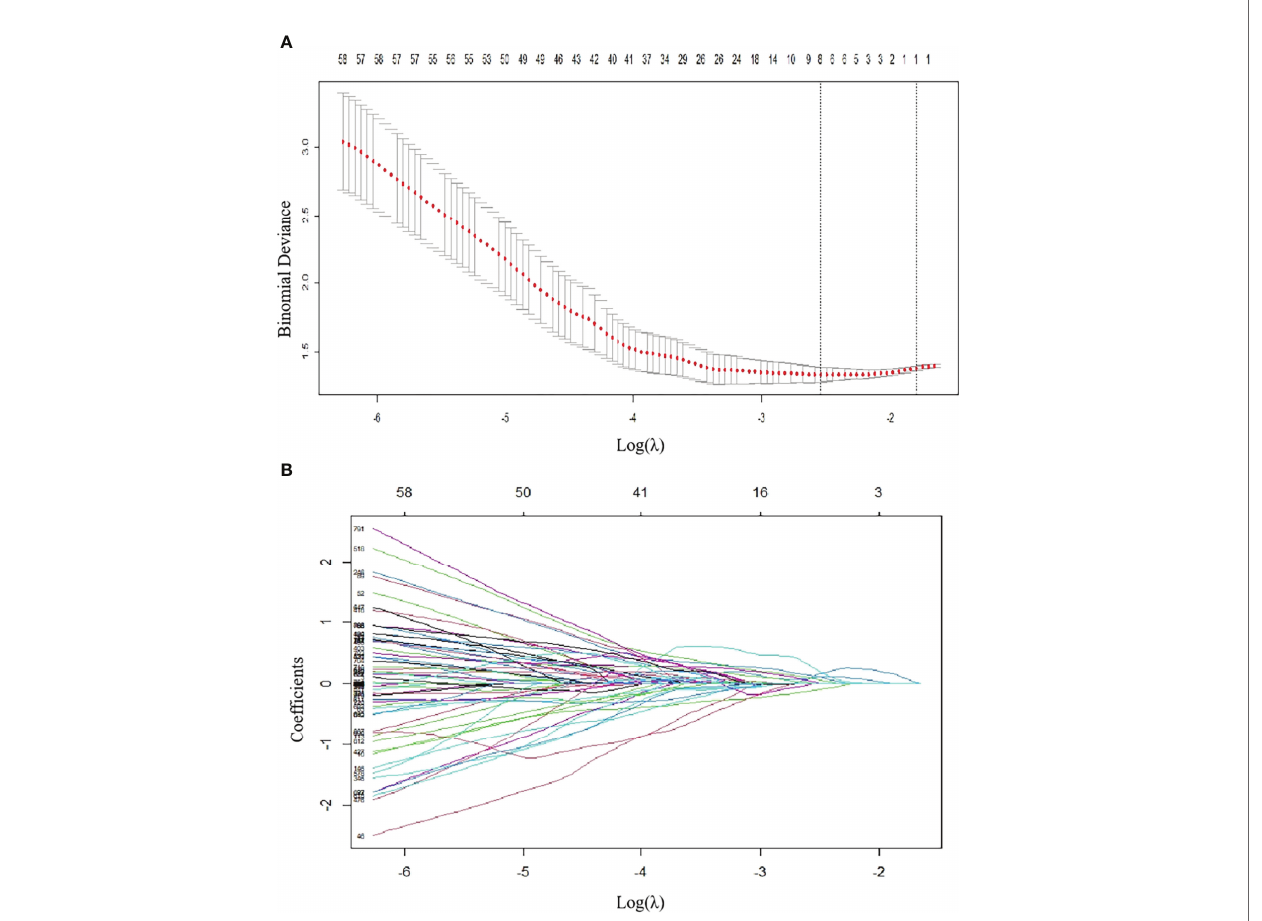
FIGURE 2 | Radiomics feature selection using LASSO regression in the training group. (A) Via 7-fold cross-validation(CV), the value of l that gave the minimum average binomial deviance was used to select features. The y-axis shows binomial deviances and the lower x-axis the log( l ). Numbers along the upper x-axis indicate the average number of predictors. Red dots indicate average deviance values for each model with a given l , and vertical bars through the red dots indicate the upper and lower values of the deviances. By using the minimum criteria and the 1 standard error of the minimum criteria (the 1-SE criteria), the vertical black lines